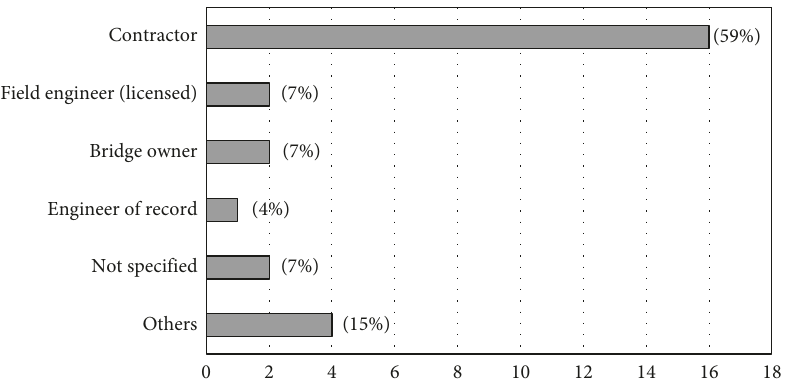
Figure 5: Party responsible for ensuring demolition plans executed as planned.